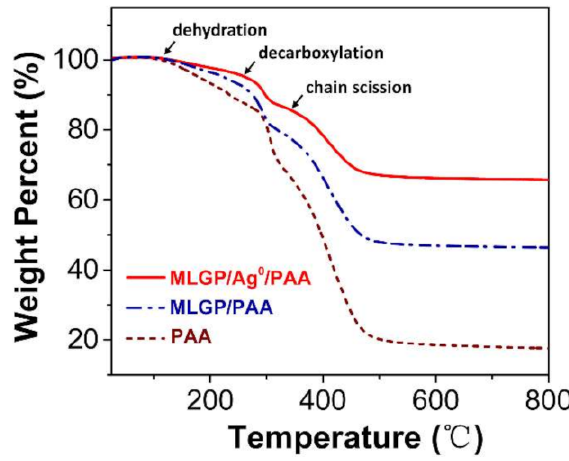
Figure 6. TGA curves of three different hydrogels. The brown, blue, and red lines indicate pure PAA, MLGP/PAA, and MLGP/ Ag 0 /PAA hydrogels, respectively.